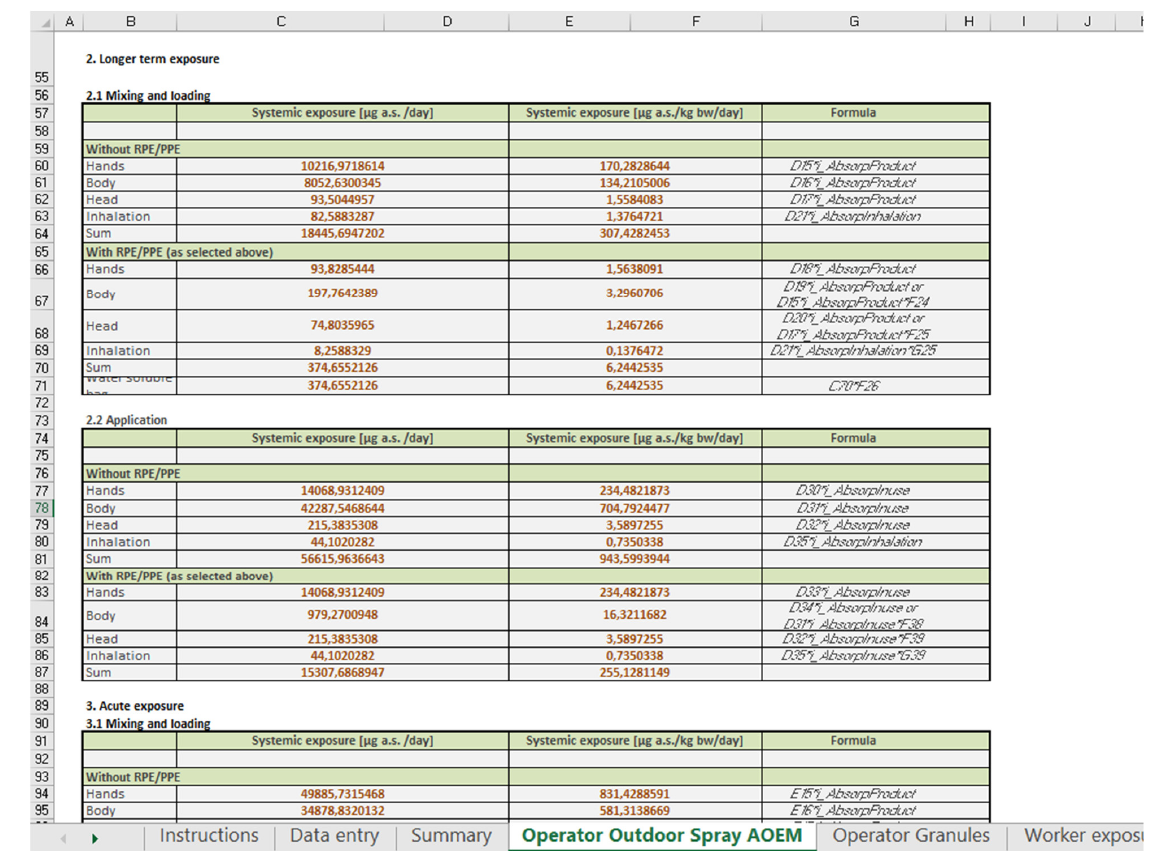
Figure A3. Operator Outdoor Spray AOEM worksheet